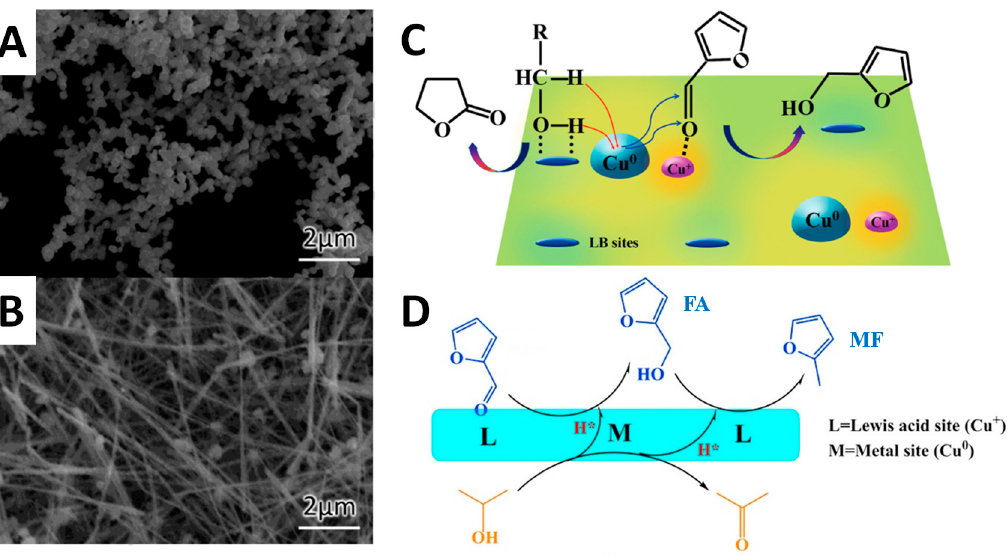
Figure 2. Scanning Electron Microscopy (SEM) images of A . Cu nanodisk and B . Cu